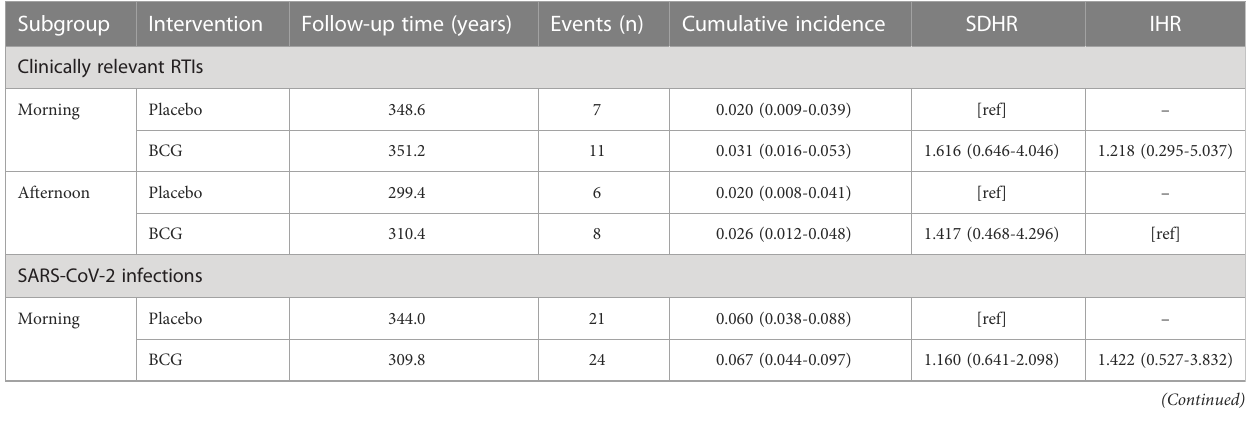
TABLE 2C Effect of morning and afternoon BCG vaccination compared to placebo in the full 12 months follow-up.